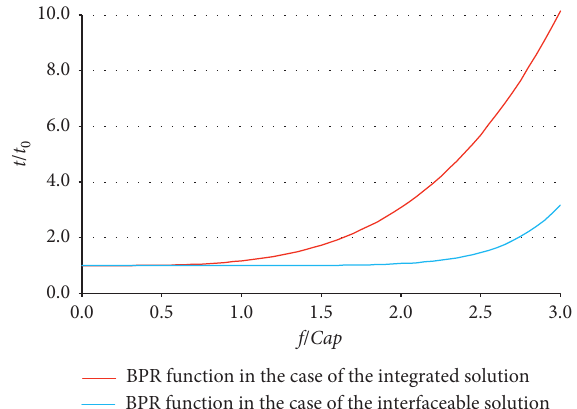
Figure 15: Comparison between the two approaches analysed (i.e., integrated vs interfaceable solution) in terms of BPR function cost.